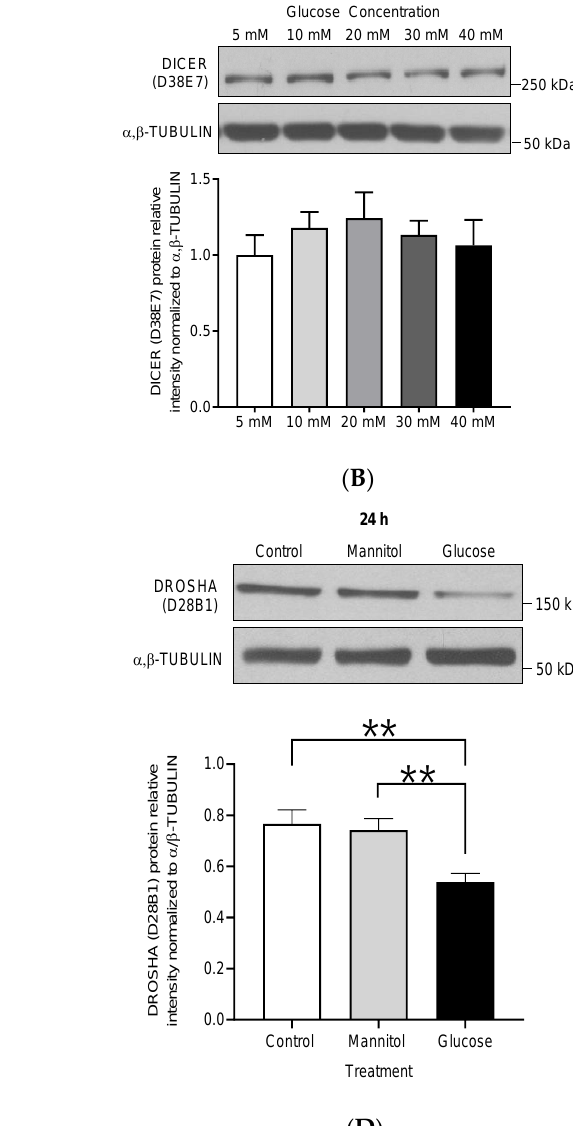
cular endothelial cells (HDMECs). Immunoblots of ( A ) DROSHA (D28B1) and ( B ) DICER (D38E7) in human primary HDMECs